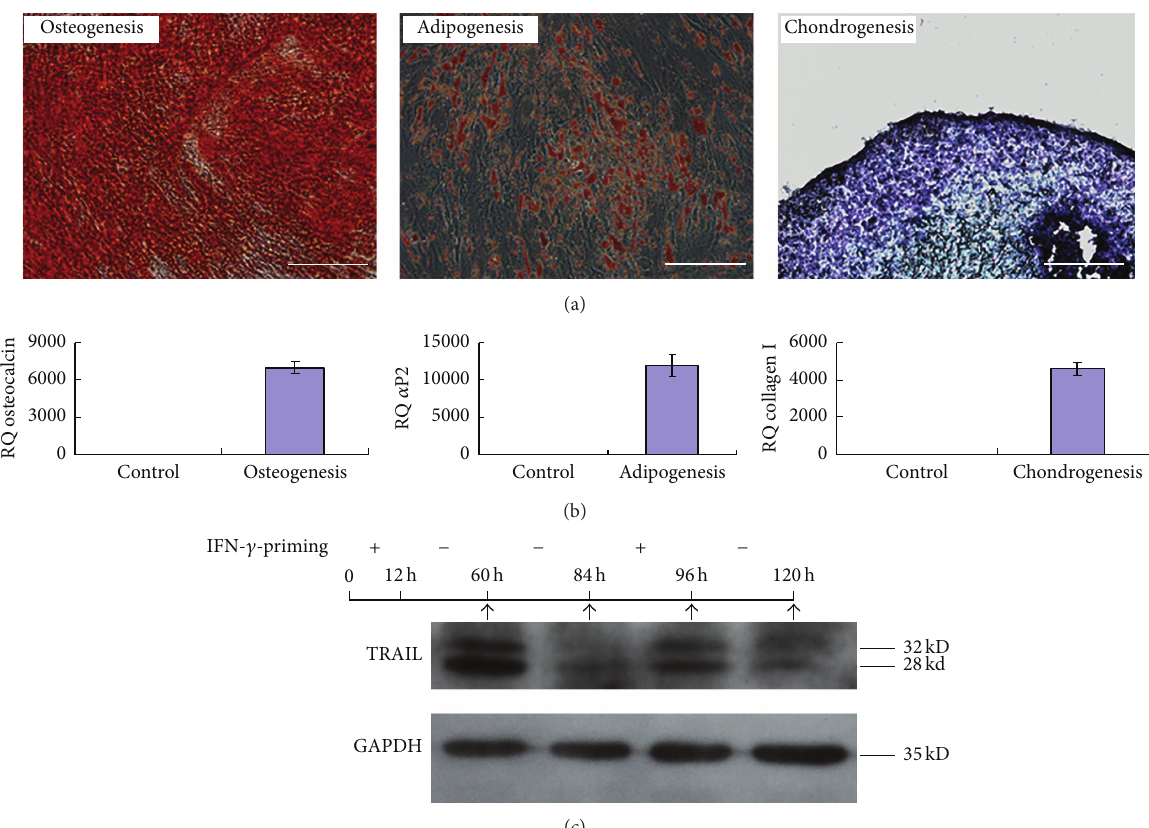
Figure 1: The characteristics of MSCs were analyzed. (a) The osteogenic, adipogenic, and chondrogenic differentiation of MSCs were identified by alizarin red S staining, oil red O staining, and alcian blue staining, respectively. Scale bar: 200 𝜇 m. (b) After 7 days of induction, the expression of genes involved in osteogenic, adipogenic, and chondrogenic differentiation was measured using quantitative real-time PCR and normalized to GAPDH expression. (c) TRAIL expression in MSCs undergoing IFN- 𝛾 -priming was analyzed by Western blotting. IFN- 𝛾 -primed MSCs showed reduced expression of TRAIL after the removal of IFN- 𝛾 but continuously expressed TRAIL when stimulated again with IFN- 𝛾